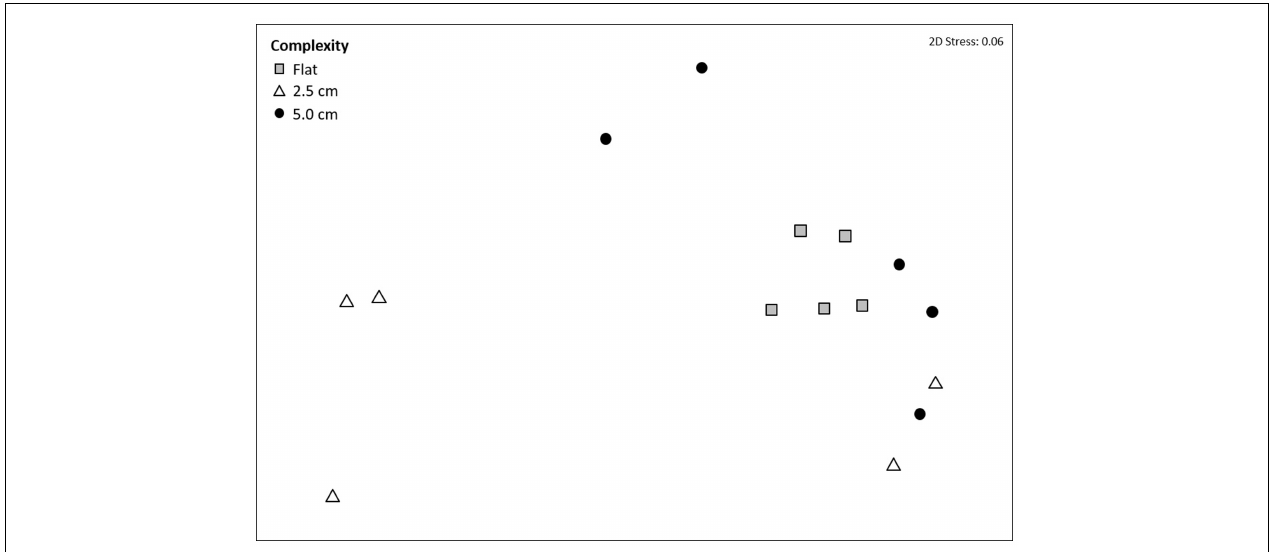
FIGURE 3 | Non-metric multi-dimensional scaling (nMDS) ordination on Bray–Curtis resemblances using square root transformed multivariate data showing the effects of physical complexity on community composition at a marina in Tel Aviv, Israel (eastern Mediterranean Sea). Community data were collected from subtidal flat tiles (without crevice and ridges), 2.5 cm complexity tiles and 5.0 cm complexity tiles at the end of the 12-month experiment (August 2016–August